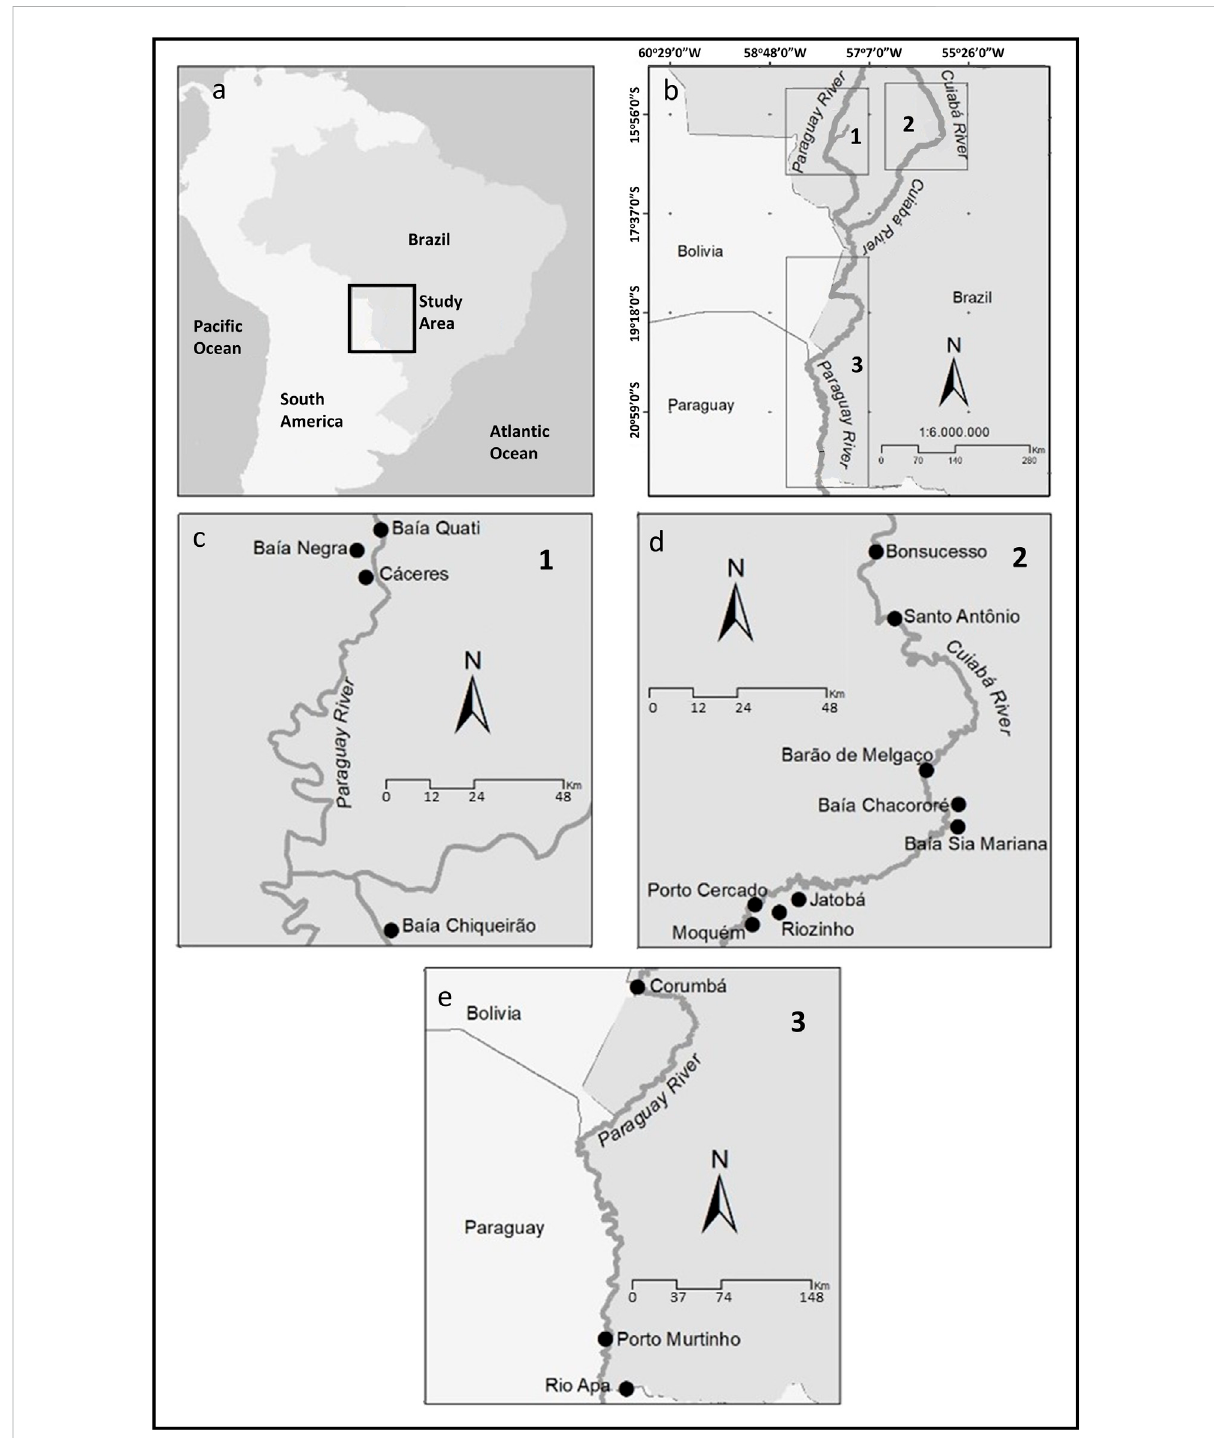
FIGURE 1 StudyareaandmicroplasticsamplingsitesinthePantanal. (A) LocationofthestudyareainSouthAmerica. (B) Locationofthesamplingzonesin The Pantanal: 1- Upper Paraguay Zone; 2- Cuiabá River Zone; 3- Lower Paraguay Zone. (C) Sampling locations of the Upper Paraguay Zone. (D) Sampling locations of the Cuiabá River Zone. (E) Sampling locations of the Lower Paraguay Zone. Dots represent the sampling